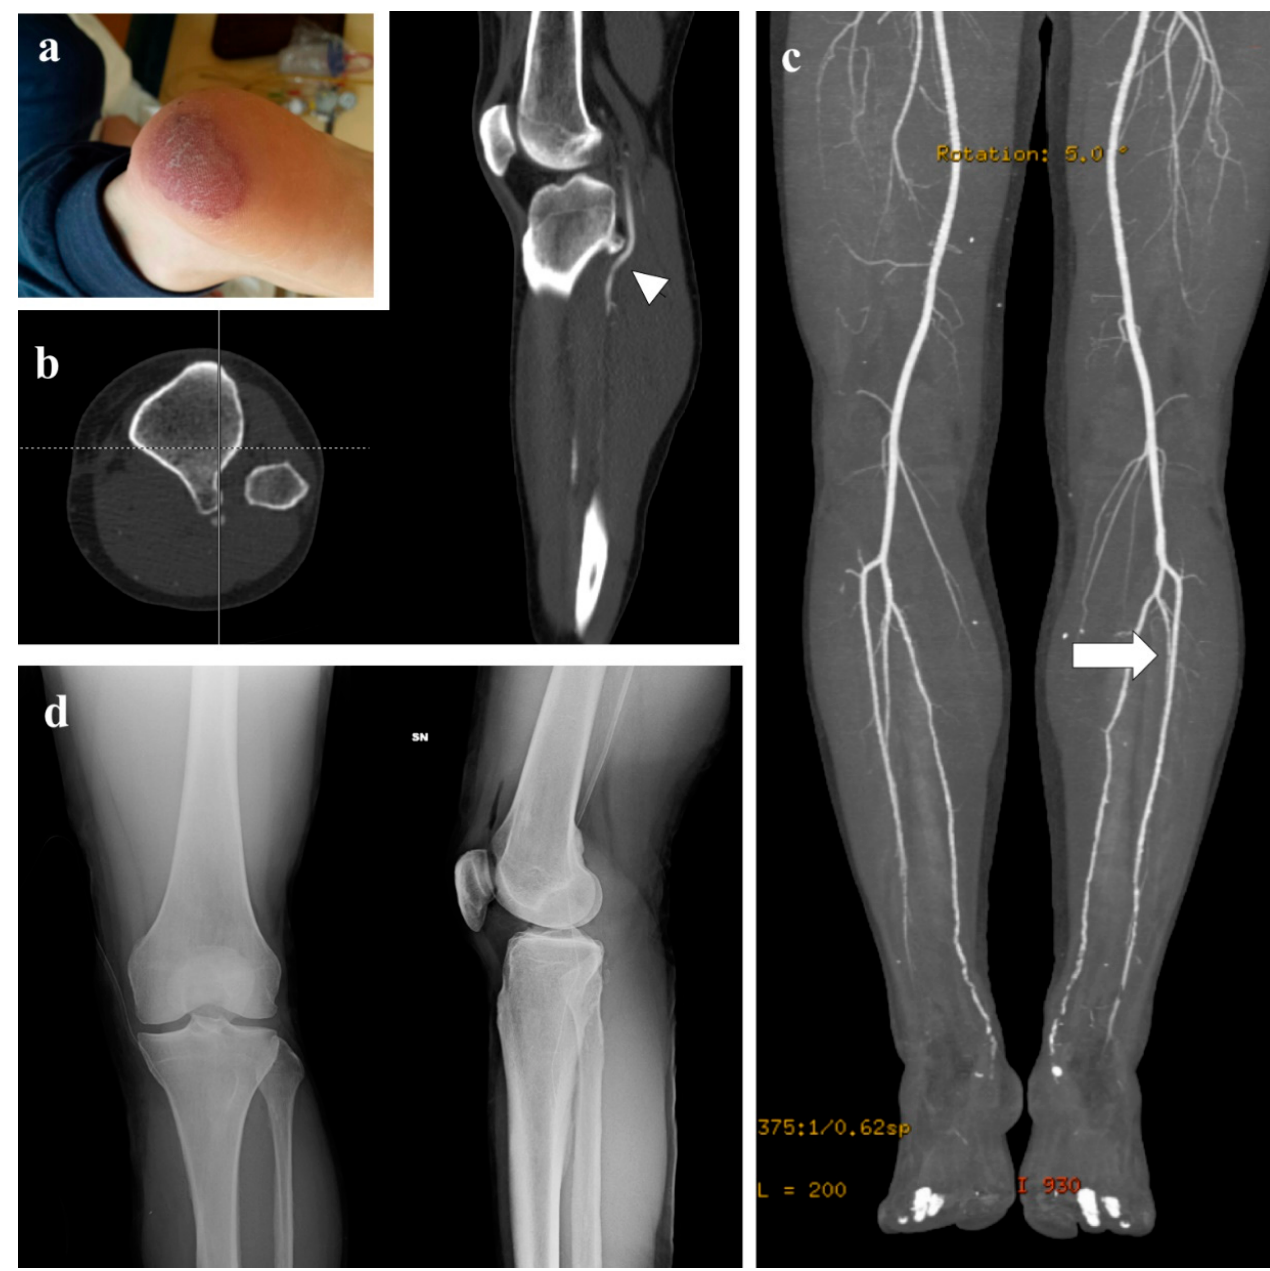
Figure 1. ( a ) Ecchymosis at left heel. ( b ) Typical imaging appearance at axial and sagittal CT scan, with pedunculated osteochondroma with posterior extension and compression of arterial bundle (arrow head). ( c ) CT Angiogram show thrombosis of the subarticular popliteal artery (white arrow). ( d ) antero-posterior and lateral radiograph appear less representative for clear diagnosis of the bony lesion. Physical examination revealed loss of popliteal and peripheral pulses whereas the ipsilateral femoral pulses were normal, with no neurological deficit of the affected limb. A CT scan revealed an osteochondroma on the posterior face of the tibial plateau, close to the vascular bundle (Figure 1b), and the CT angiogram showed thrombosis of the subarticular popliteal artery (Figure 1c). Plain radiographs (Figure 1d) and contrast-enhanced MRI showed the pedunculated tumor with a thin cartilaginous cup (Figure